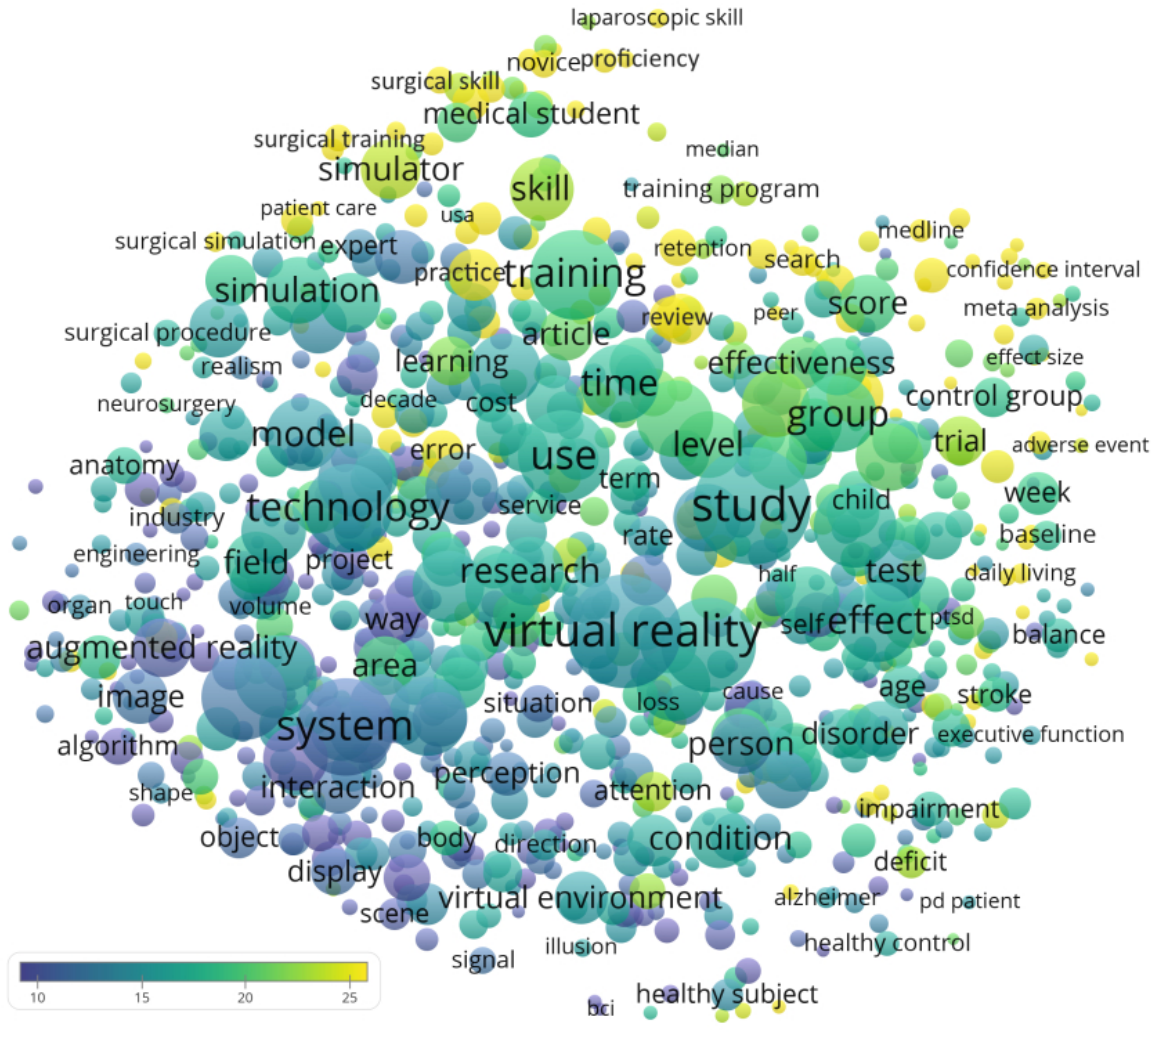
Figure 2. Term map showing phrases from publication titles and abstracts in virtual reality research in medicine. Phrases occurring in at least 0.5% (42/8399) of the publications were included. Multiple appearances in a single publication counted as one. Circle size represents the frequency of occurrence, color represents the citation per publication, and distance between 2 circles represent how 2 phrases co-occurred in the